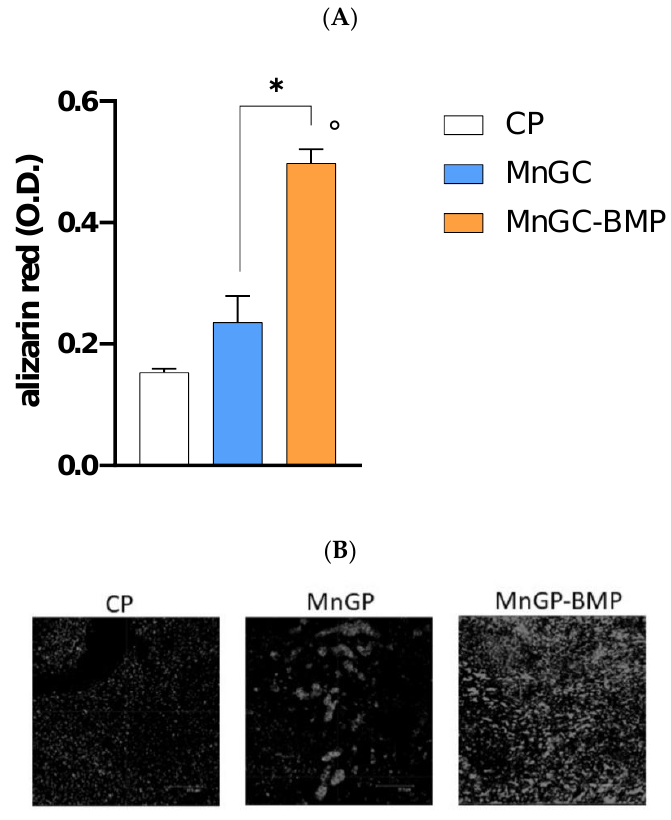
Figure 11. Calcium salt deposition was assessed by alizarin red staining in h-osteoblast cells cul- tured for 7 days on plastic supports (CP), MnGC, or MnGC-BMP. ( A ) Alizarin red was recorded using spectrophotometry. O.D. — optical density. Data are reported as mean ± standard error of 3 independent experiments, each performed in duplicate. ° indicates p < 0.02 vs. CP; * indicates p < 0.02. ( B ) In a parallel set of experiments, stained samples were visualized using a Leica microscope. Representative images. Scale bar = 37.5 μm.